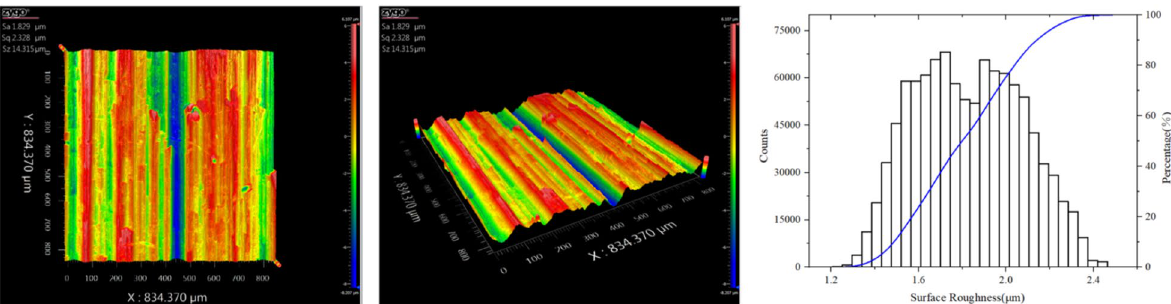
Figure 8 ( f 0.3 mm/r, v 260 m/min) 3D morphology, 2D morphology and roughness distribution curve of machined surface = =